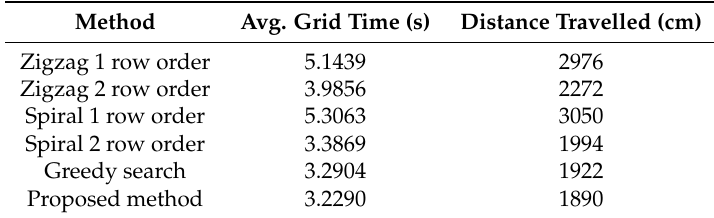
Figure 18. Heat map output of each considered algorithm for 11 × 11 workspace. ( a ) Zigzag scanning 1 row order; ( b ) Zigzag scanning 2 row order; ( c ) Spiral scanning 1 row order; ( d ) Spiral scanning 2 row order; ( e ) Greedy search; ( f ) Proposed method. Table 4. Path planning performance of navigation simulation.